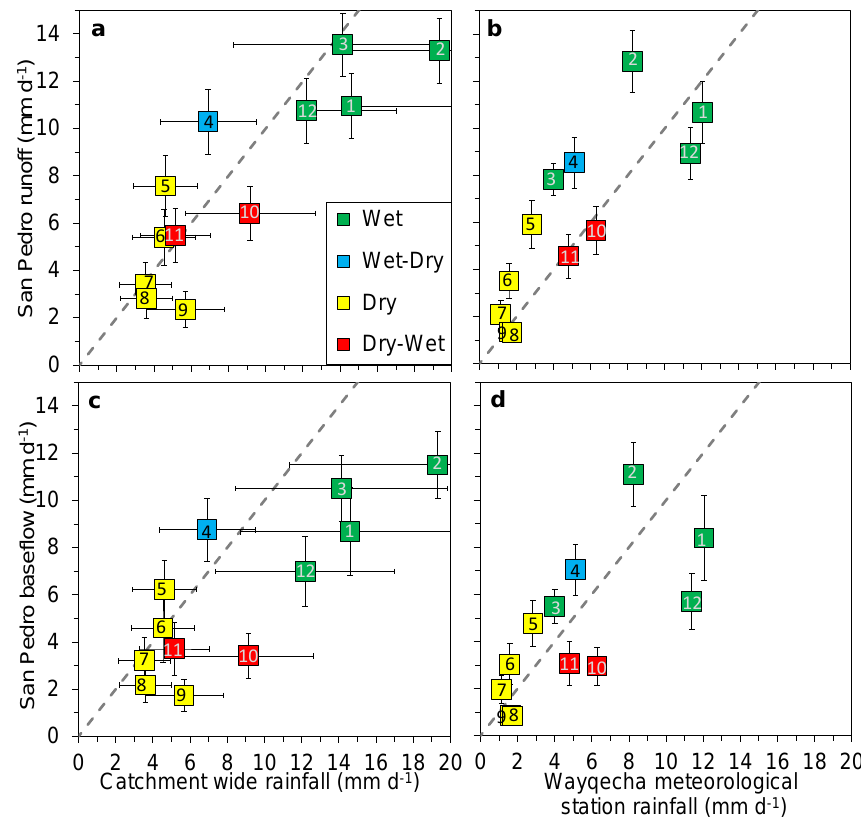
Figure 10. Mean monthly rainfall (corrected for wind-induced loss) versus river run-off (mmd − 1 ) for the Kosñipata catchment, showing anticlockwise hysteresis throughout the year, with months numbered chronologically and colour-coded by season (see Figs. 2 and 7). Plots show stream run-off versus (a) catchment-wide rainfall and (b) meteorological station rainfall for the Wayqecha meteorological station (2900ma.s.l.), and baseflow versus (c) catchment-wide rainfall and (d) meteorological station rainfall at Wayqecha. Error bars represent 1 standard deviation. The one-to-one line for rainfall to river run-off is represented by the grey dashed line. Note: in (b) and (d) days with zero rainfall were excluded as per the approach used by Andermann et al.